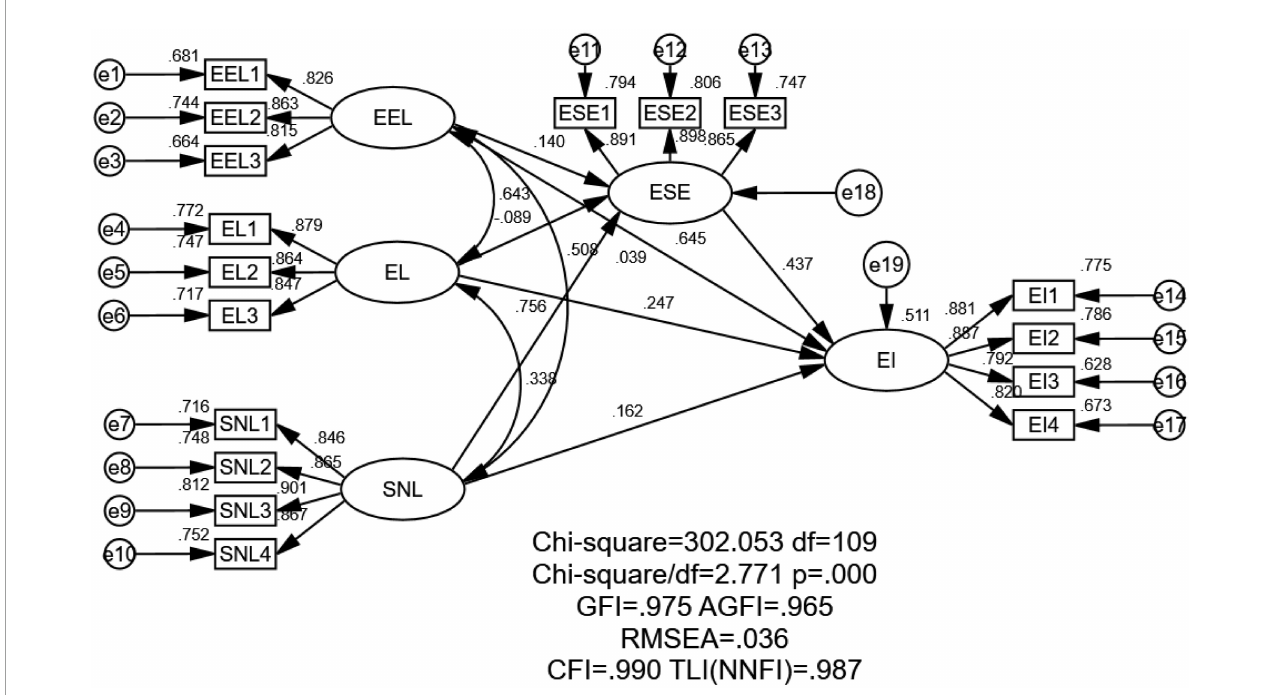
FIGURE2 Structural equation model results. EI, entrepreneurial intention; EEL, entrepreneurial education learning; EL, experiential learning; ESE, entrepreneurial self-efficacy; SNL, social network